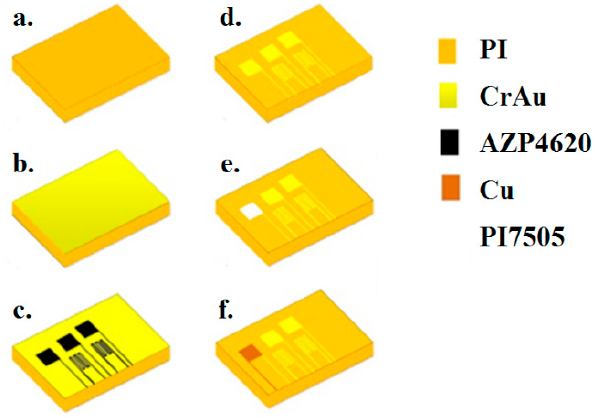
Figure 6. Process of flexible five-in-one microsensor.